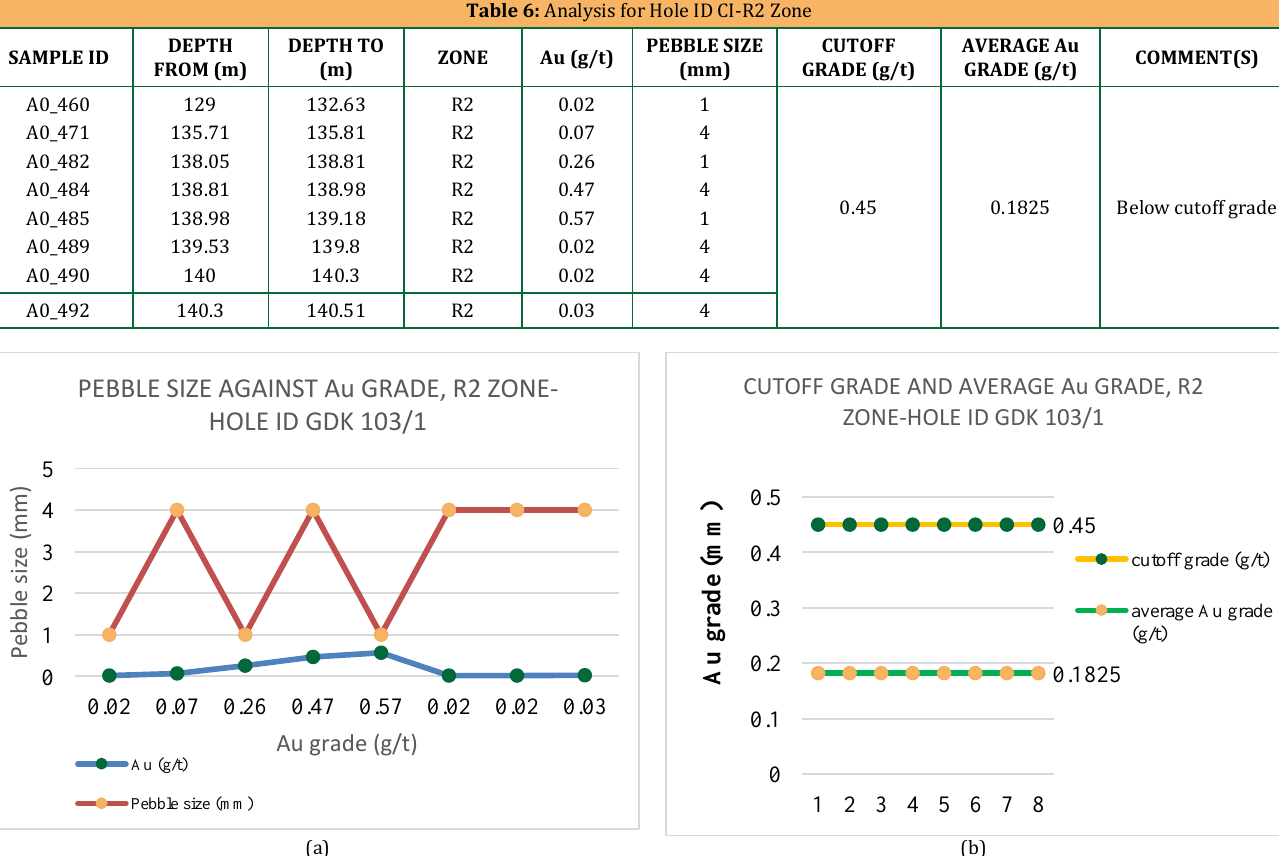
Table 6: Analysis for Hole ID CI-R2 Zone